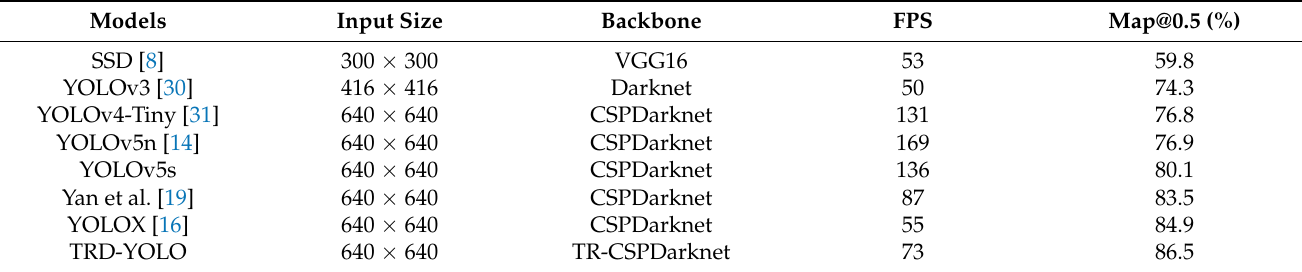
Table 2. The detection performance comparison of different methods on the TT100K dataset.